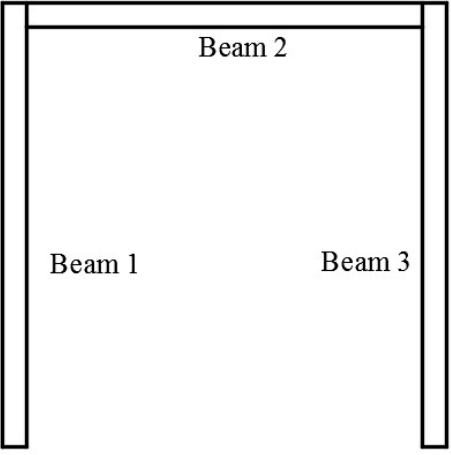
Figure 8. The division result of the gantry structure.